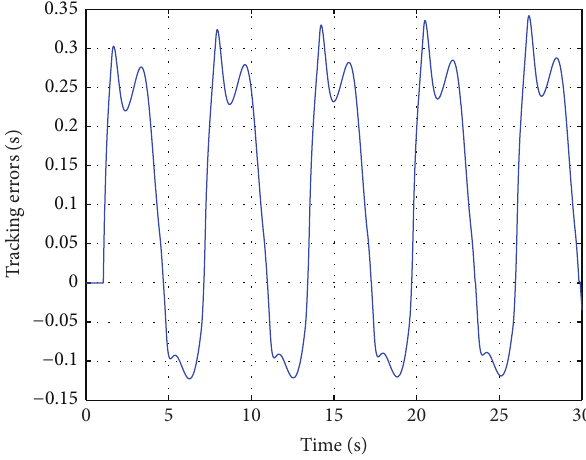
Figure 14: Tracking error 𝑠(𝑡) versus